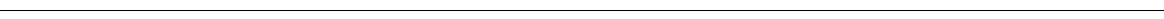
Fig. 5 Methylation pro fi les of imprinted DMRs in primary TCGA cancer samples. a Scatter plots for imprinted domains on chromosome 20 in tumor, adjacent and control somatic DNA reveals that the CNAs are restricted to the cancer samples. b Ideogram for chromosome 20 showing the extent of ampli fi cations and deletions for MCTS2, NNAT, L3MBTL1 and GNAS domains in lung-derived cancer samples. Ampli fi cations are in red and deletion in blue with the width of the lines representing the total copy-number for each aberration. c Stacked histograms ranked according to the severity and number of affected loci per sample. The graphs in the left column reveal that cell lines with the highest hypermethylation burden for CIMP regions are similarly hypermethylated at bivalent domains. The middle column is a comparison between the methylation pro fi les of imprinted DMRs irrespective of CNA status and CIMP. The right row is the same comparison but with only imprinted domains with a normal copy-number. For each type of loci the number of genes analyzed is indicated on the x -axis. d Line graph of the number of cancer samples showing methylation defects in imprinted DMRs. Control DNA methylation frequencies are depicted by black solid line with a β -value near 0.5 indicative of one methylated and one unmethylated allele. Dashed red line represents total methylation defects irrespective of the underlying CNA status, whereas solid red line represents the methylation pro fi les in samples carrying normal 2:1 copy number complement. e The observed vs. expected methylation pro fi le for the GNAS A/B DMR overlapping exon 1A in lung tumors. The dashed lines represent the ± 3 s.d. of the mean of normal control tissues. Data points outside this range are deemed to have a